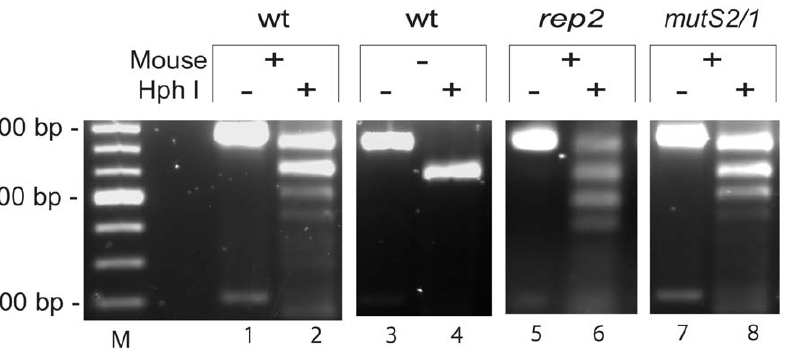
Figure 2. Restriction fragment length polymorphism assay for switching at vlsE . A portion of the vlsE expression site containing the variable regions was amplified using primers B248 and B249 to give a product of 776 bp. PCR reactions were performed on B. burgdorferi grown from ear biopsies taken at day 21 and the products were digested with HphI and run on a 1.2% agarose gel in TAE buffer at 75V for 1.5 hours and stained with ethidium bromide (see Materials and Methods). Wild-type B. burgdorferi B31-5A4 recovered following infection of a C3H/HeN mouse was used as a template in lanes 1 and 2. An unswitched template (not exposed to mouse infection) is shown in lanes 3 and 4. PCR products from rep2 and mutS2 / 1 DNA templates are found in lanes 5 & 6, and 7 & 8 respectively. M denotes a 100bp molecular weight marker.